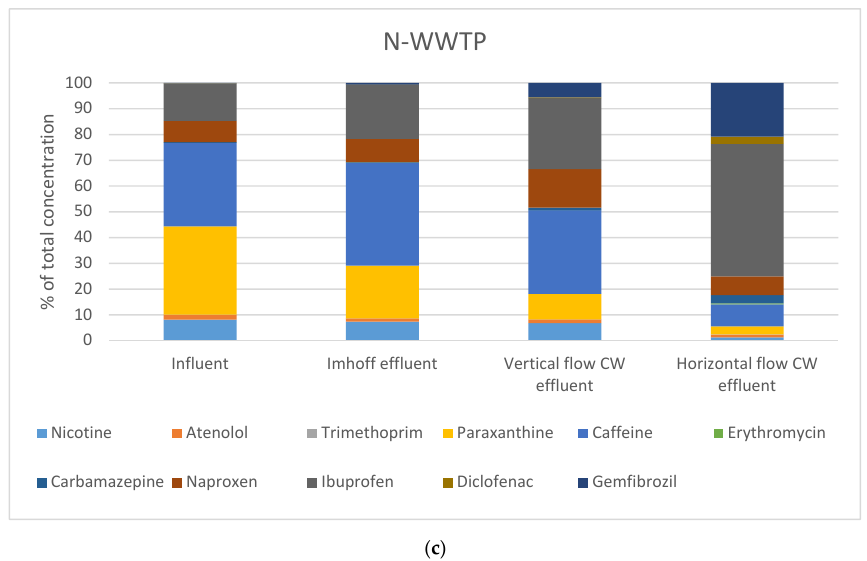
Figure 2. Distribution of pharmaceuticals from Table 1. ( a ) C-WWTP1, ( b ) C-WWTP2, ( c ) N-WWTP.